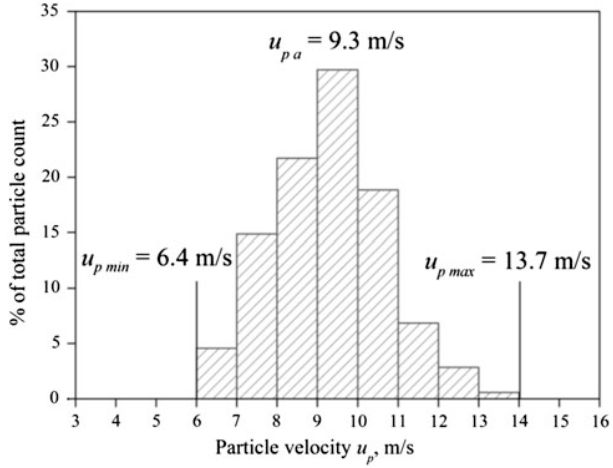
Figure 10. Distribution of particles velocities at a distance of 30 mm below the nozzle exit (reproduced with permission from [67]; Copyright © 2010 Springer Nature).